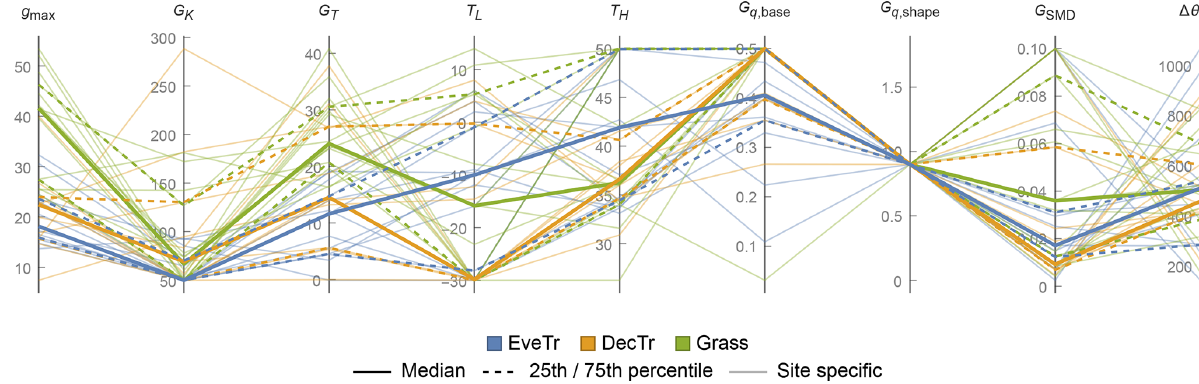
Figure 10. As Fig.5, but for surface-conductance-related parameters.